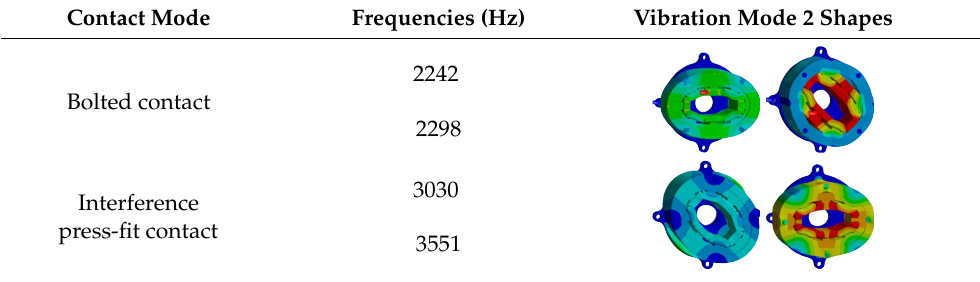
Table 4. Natural frequencies for the bolted and interference press-fit contacts for the 8/6 SRM.